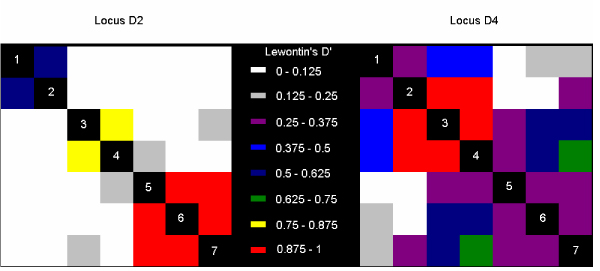
Matrices indicating the extent of LD at loci D2 and D4.